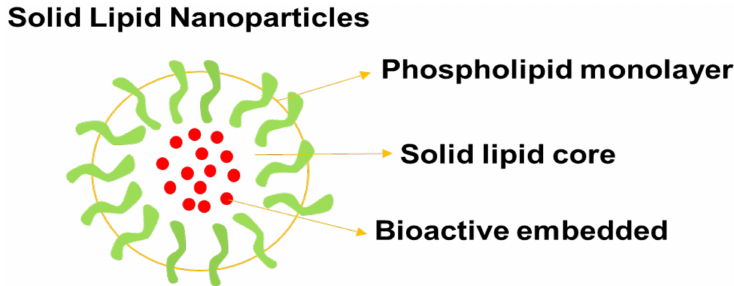
Figure 6. A schematic diagram of solid lipid